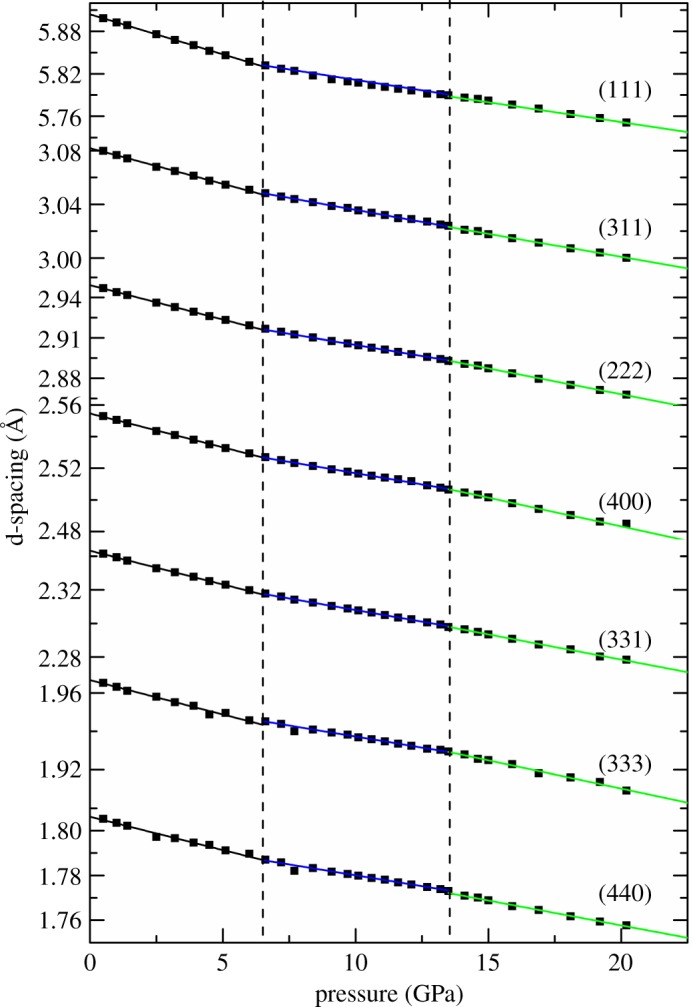
The d-spacing of Gd1.5Ce0.5Ti2O7 as a function of pressure. The black, blue and green lines are different regions (p < 6.5 GPa, 6.5 GPa < p < 13.5 GPa, and p > 13.5 GPa, respectively).